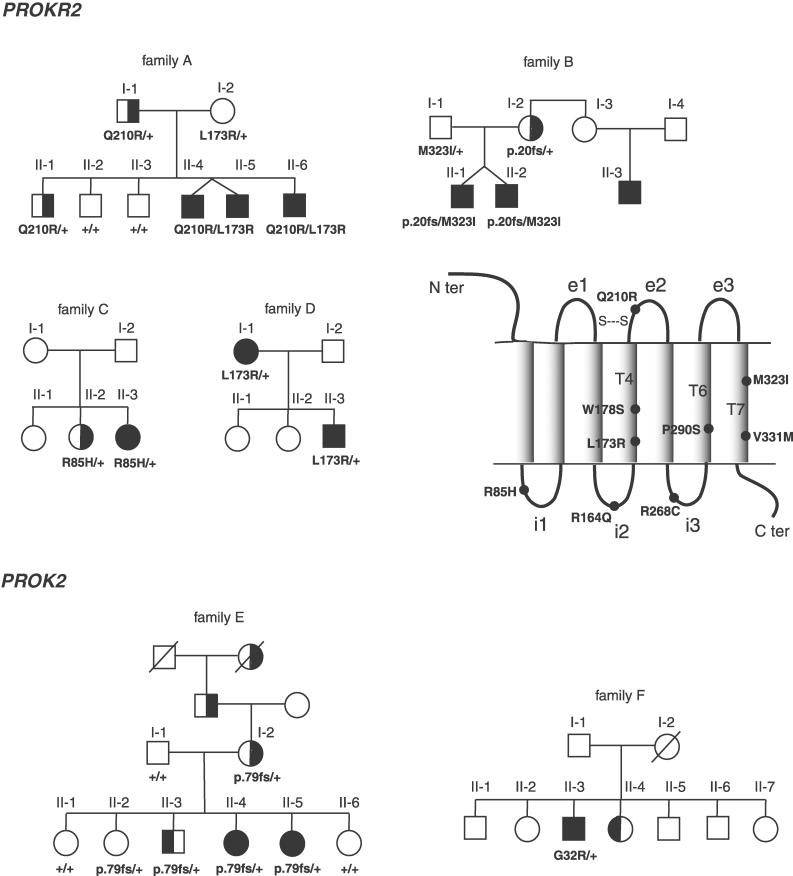
Segregation of Kallmann Syndrome and the PROKR2 or PROK2 Mutations in Affected FamiliesFilled symbols denote clinically affected individuals with both hypogonadism and anosmia (or hyposmia). Half-filled symbols denote individuals with either anosmia only (right black part) or hypogonadism only (left black part). Genotypes, if available, are indicated below. The symbol + denotes normal allele, and fs stands for frameshift mutation. In several pedigrees the mutation is associated with varying phenotypes. Notably, in family A the disease apparently segregates according to a semi-dominant mode of transmission. The schematic representation of PROKR2 shows the locations of the nine missense mutations found in familial and non-familial KS cases, with respect to the putative N-terminal (N ter), C-terminal (C ter), extracellular loop (e1-e3), intracellular loop (i1-i3), and transmembrane (T1–T7) domains [13] of this G protein-coupled receptor.